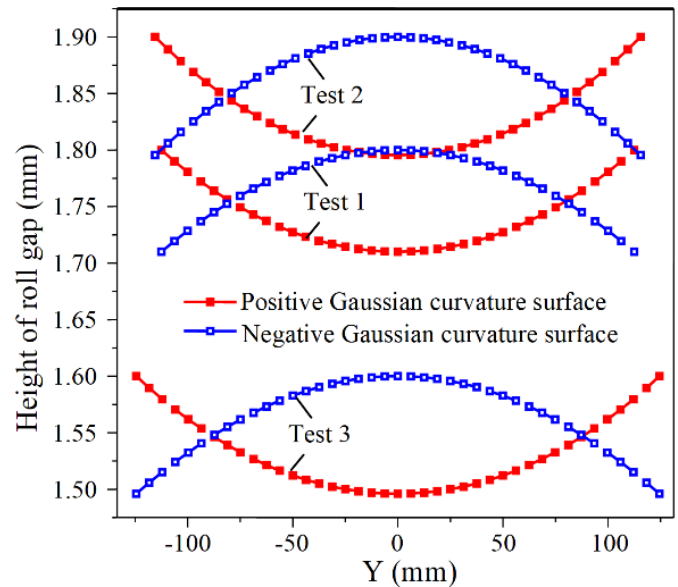
Figure 12. Distribution of the roll gap. Table 4. Arrangement of verification test.